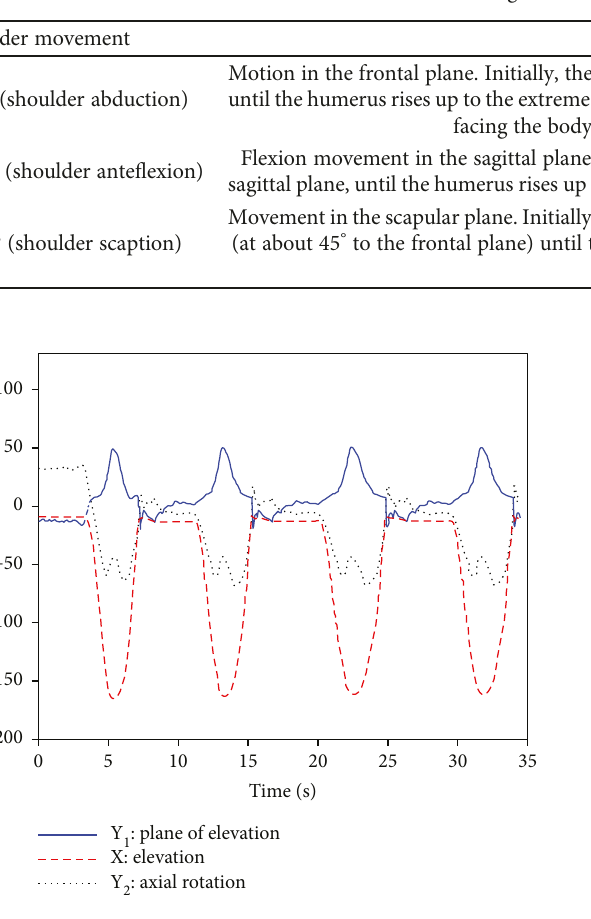
Figure 8: The joint angles θ parameters